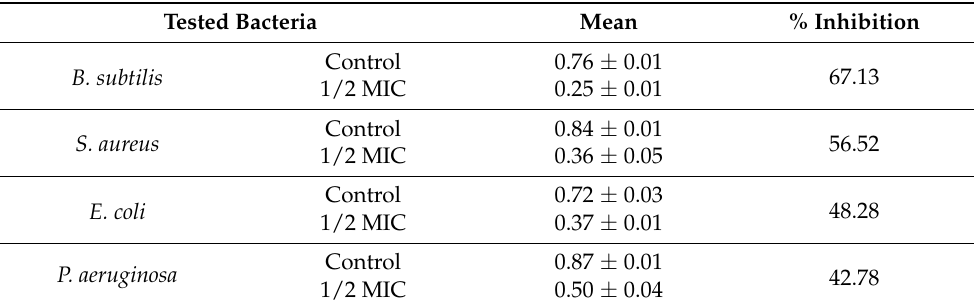
Table 4. Antibiofilm activity of the manuka honey against biofilm-forming bacterial species. Tested Bacteria